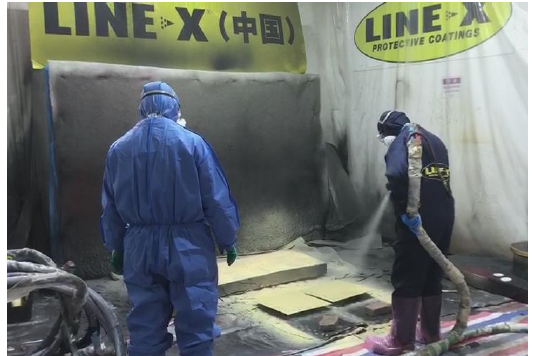
Figure 4. Polyurea spraying process using the spray polyurea elastomer (SPUA) technique.